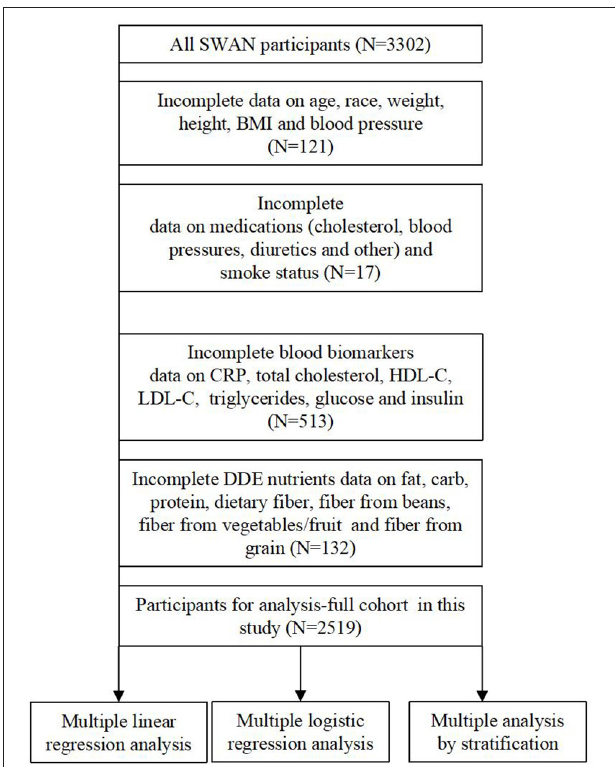
FIGURE 1 | Flow chart of the included